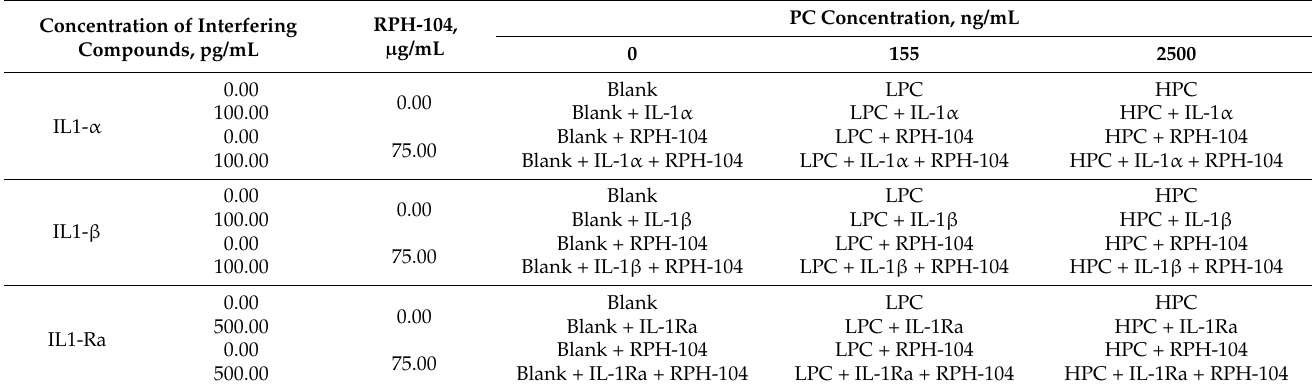
Table 2. Preparation of samples for specificity